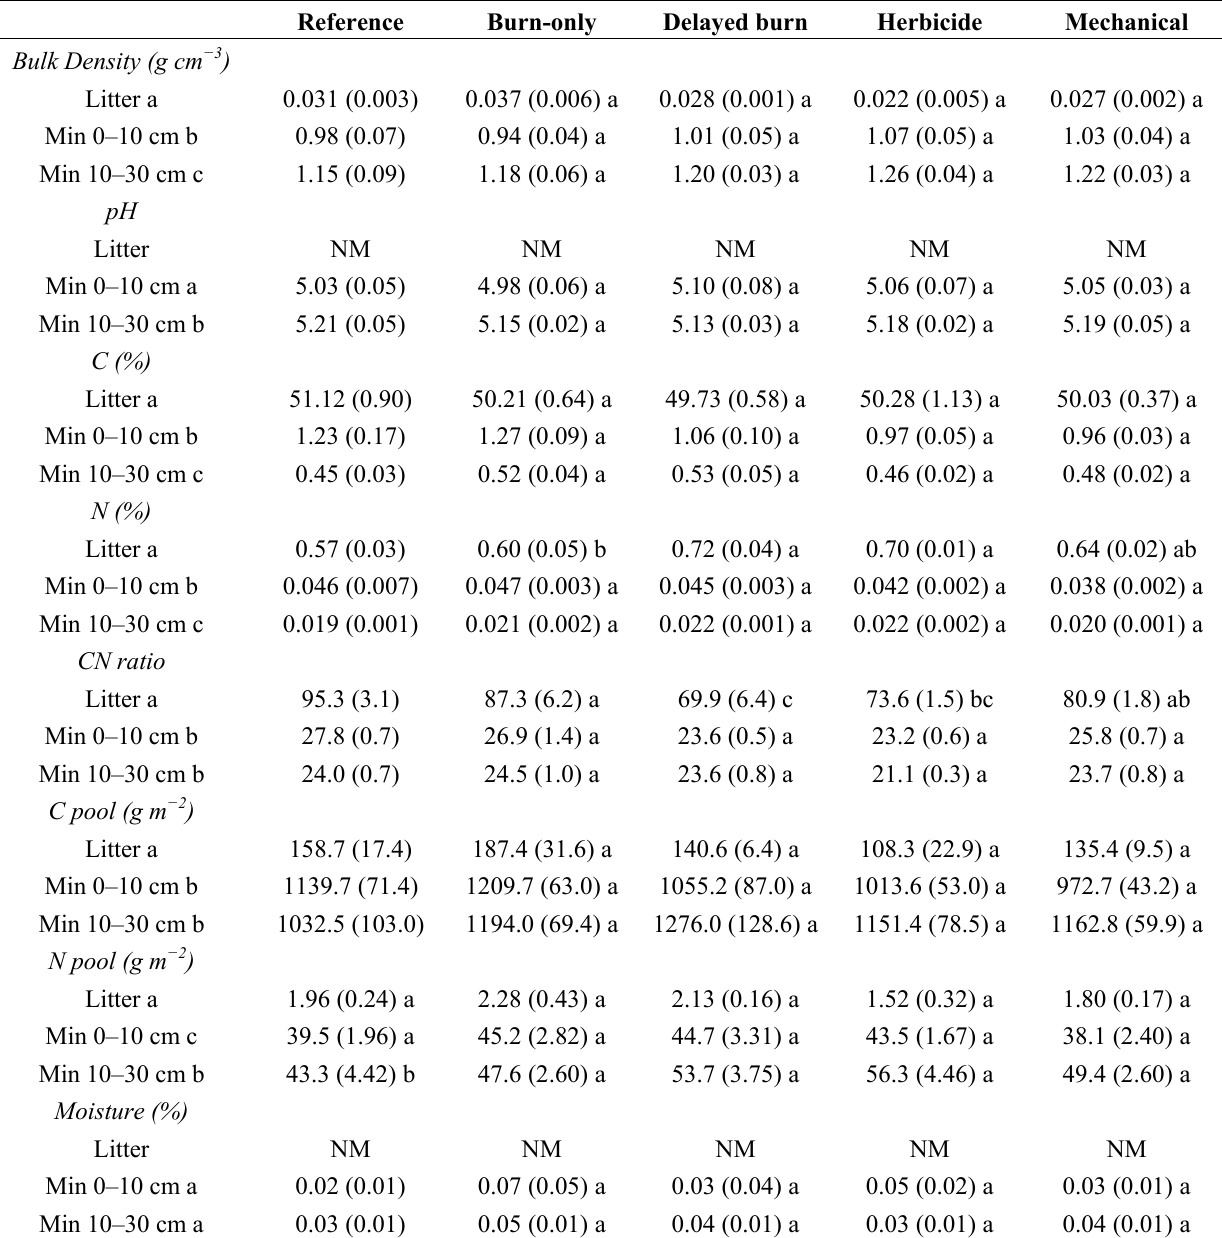
Table 4. Means and standard errors of soil characteristics for reference (not included in the GLMM testing) and restoration plots in longleaf pine forests at EAFB, Florida for summer 2009. Means for treatment or depth with the same letter do not differ at p < 0.05. NM = not